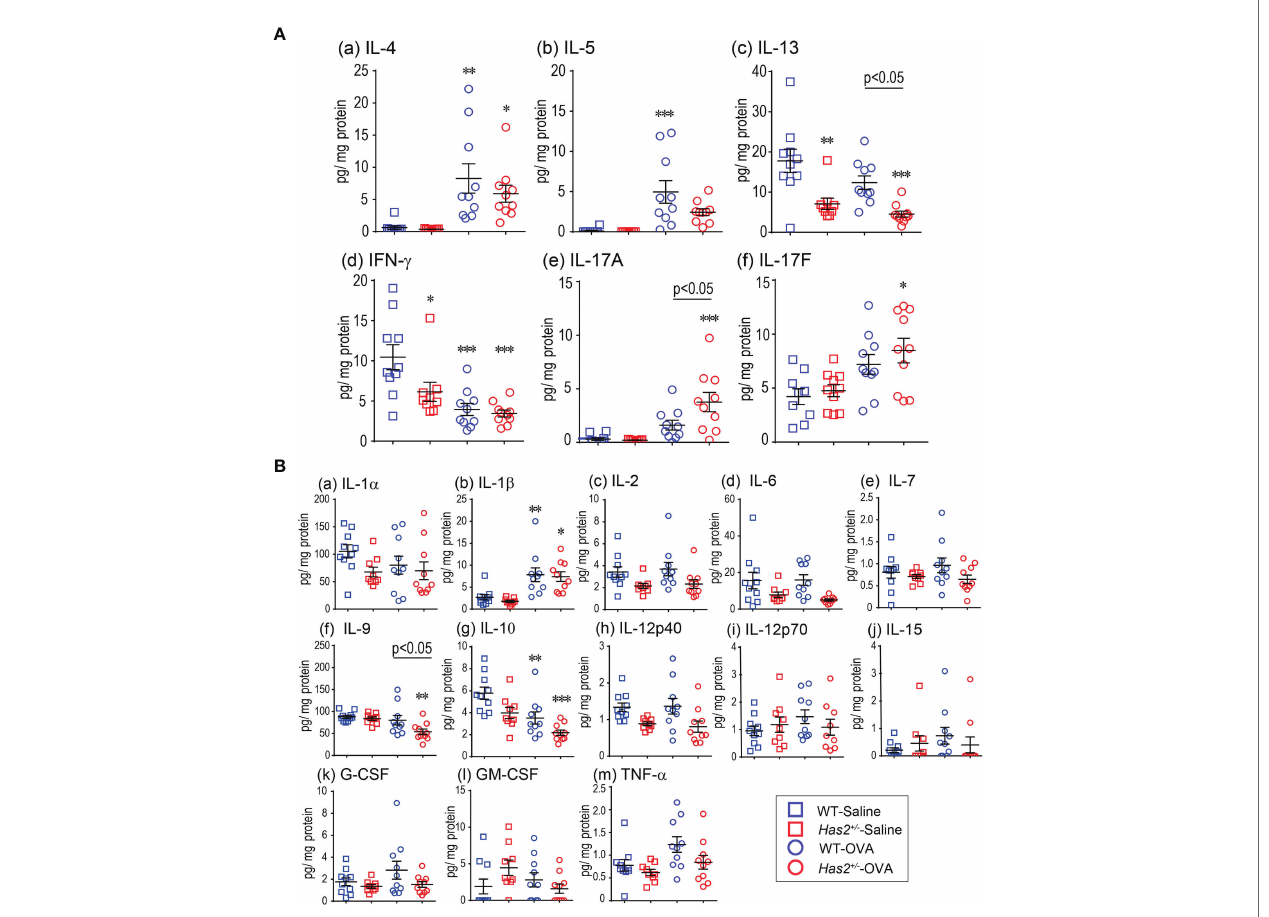
FIGURE 3 | Effects of Has2 attenuation on various cytokine and chemokine levels in lung homogenate. (A) Protein-adjusted levels of the indicated Th1/Th2- and Th17-related cytokines in lung homogenates ( n = 9 – 10). (B) Protein-adjusted levels of in fl ammatory cytokines and chemokines in lung homogenates ( n = 9 – 10). All samples are obtained 24 h after the fi nal challenge with saline or OVA. Statistical signi fi cance was determined using Tukey ’ s multiple comparison test. * P < 0.05, ** P < 0.01, and *** P < 0.001 relative to WT-saline mice. Horizontal bars indicate direct statistical comparisons between WT-OVA and Has2 +/ − -OVA